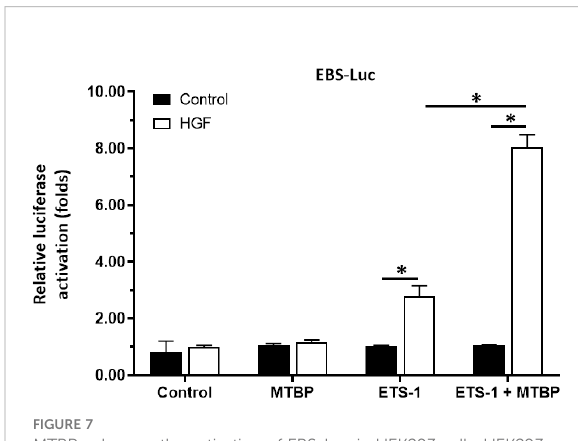
FIGURE 7 MTBP enhances the activation of EBS-Luc in HEK293 cells. HEK293 cells were cultured and co-transfected with MTBP, siMTBP or ETS-1 with EBS-Luc plasmids and treated with control or HGF. The cells were harvested for luciferase examination. *P <